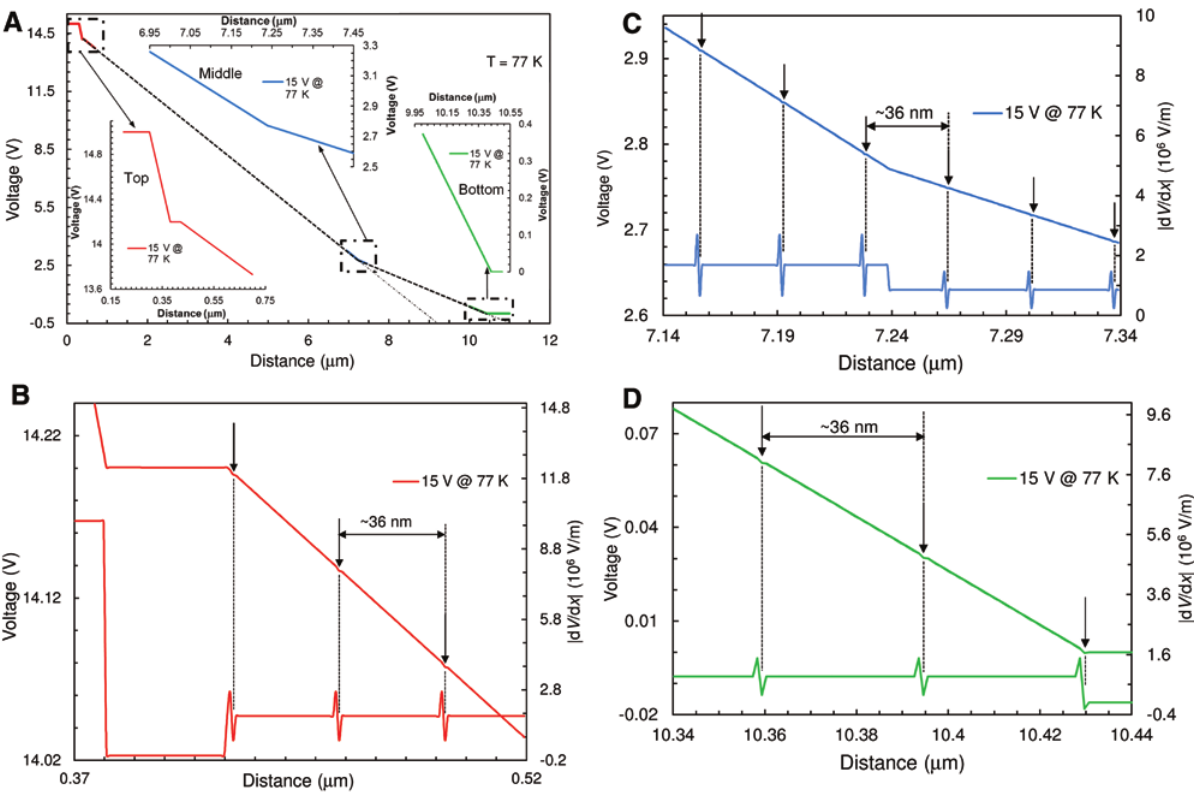
Figure 18: (A) The 1D SVM voltage curve cross the active region of the V843 device (device bias: 15 V, temperature: 77 K). The inset shows three zoomed-in SVM scans spanning 512 nm each. (B–D) are the corresponding further zoomed-in curves in which the small voltage dips at the δ -doped injection barriers can be clearly observed. The bottom curve in each figure is the first-order derivative (|d V /d x |) of the corresponding voltage profile